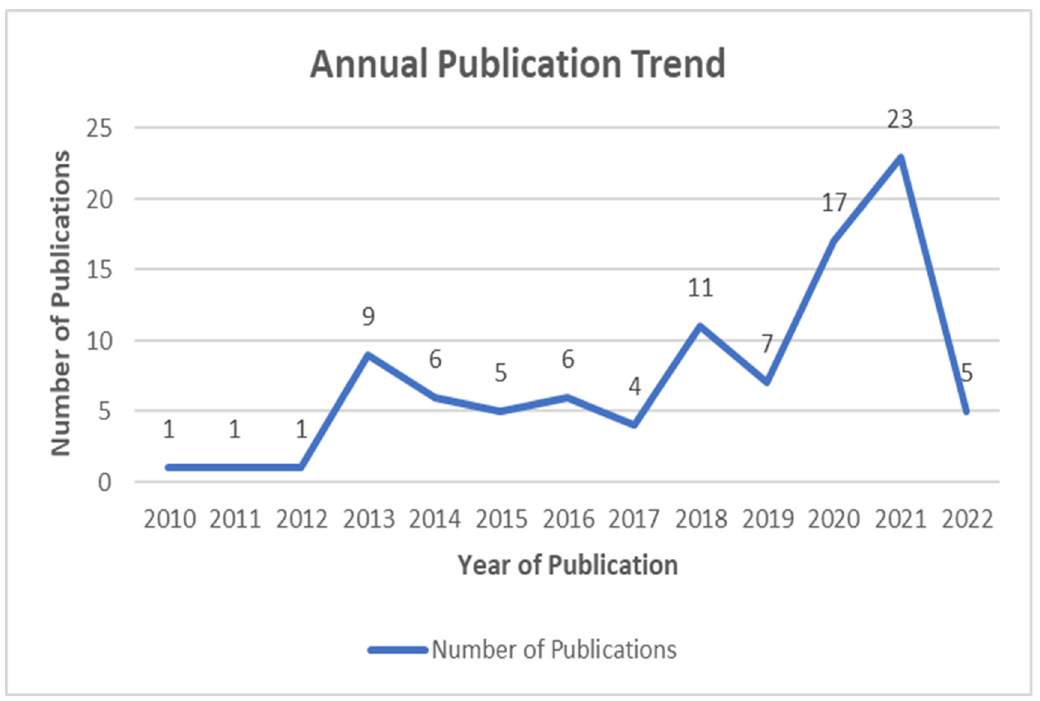
Figure 2. Annual trend of relevant publications.